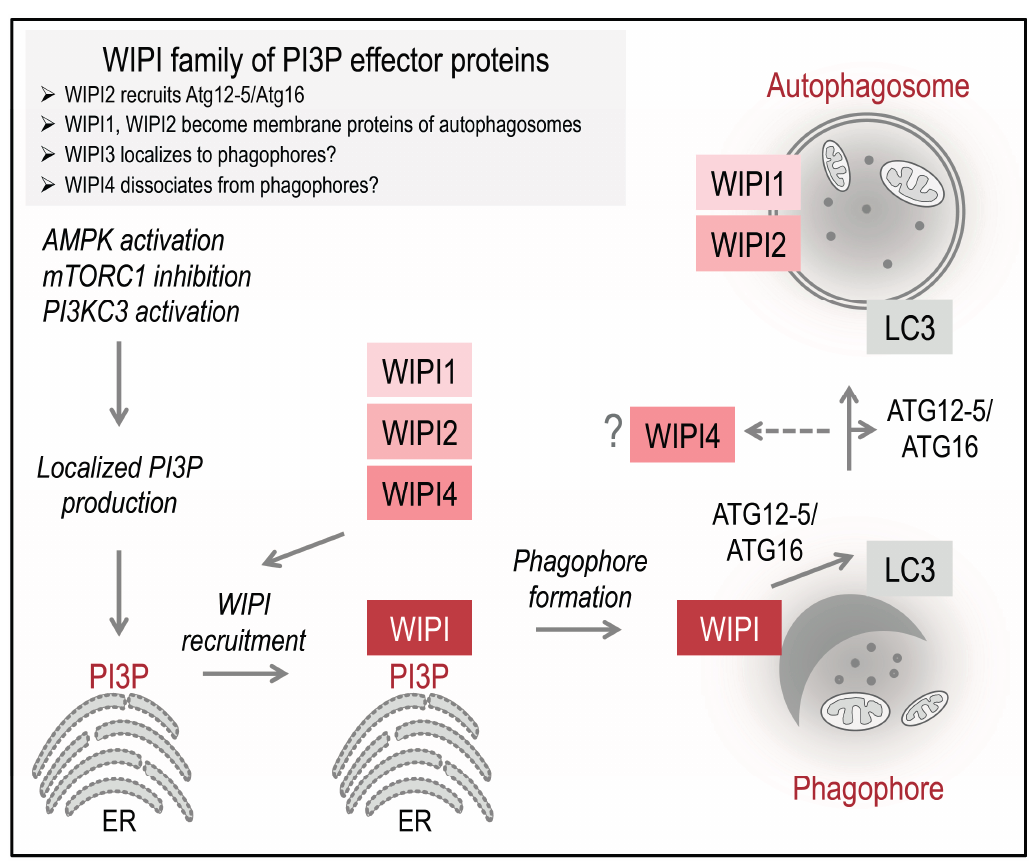
Figure 2. Working model: The PI3P-effector function of human WIPI proteins at the nascent autophagosome. Initiation of ER-localized PI3P production is regulated by the differential actions of AMPK and mTORC1 on the ULK1 complex. Following AMPK-mediated ULK1 activation, the lipid kinase PI3KC3, in complex with Beclin 1, ATG14, and Vps15, is activated to produce PI3P. Upon PI3P production, WIPI proteins are rapidly recruited to the site of autophagosome formation, where WIPI proteins specifically bind PI3P and permit the subsequent formation and proper elongation of the phagophore, as suggested for WIPI1, WIPI2, and WIPI4. Here, WIPI2B recruits the ATG12-5/ATG16 complex via binding to ATG16, permitting LC3 conjugation to PE. It is unknown whether or not WIPI3 is recruited to the phagophore. WIPI1 and WIPI2 have been detected at both the inner and outer membrane of autophagosomes. WIPI1 was further shown to colocalize with the lysosomal protein LAMP1; however, WIPI2 was not found to colocalize with LAMP2. WIPI4 might dissociate in the process of autophagosome closure and maturation. The schematic drawings of the ER was obtained from